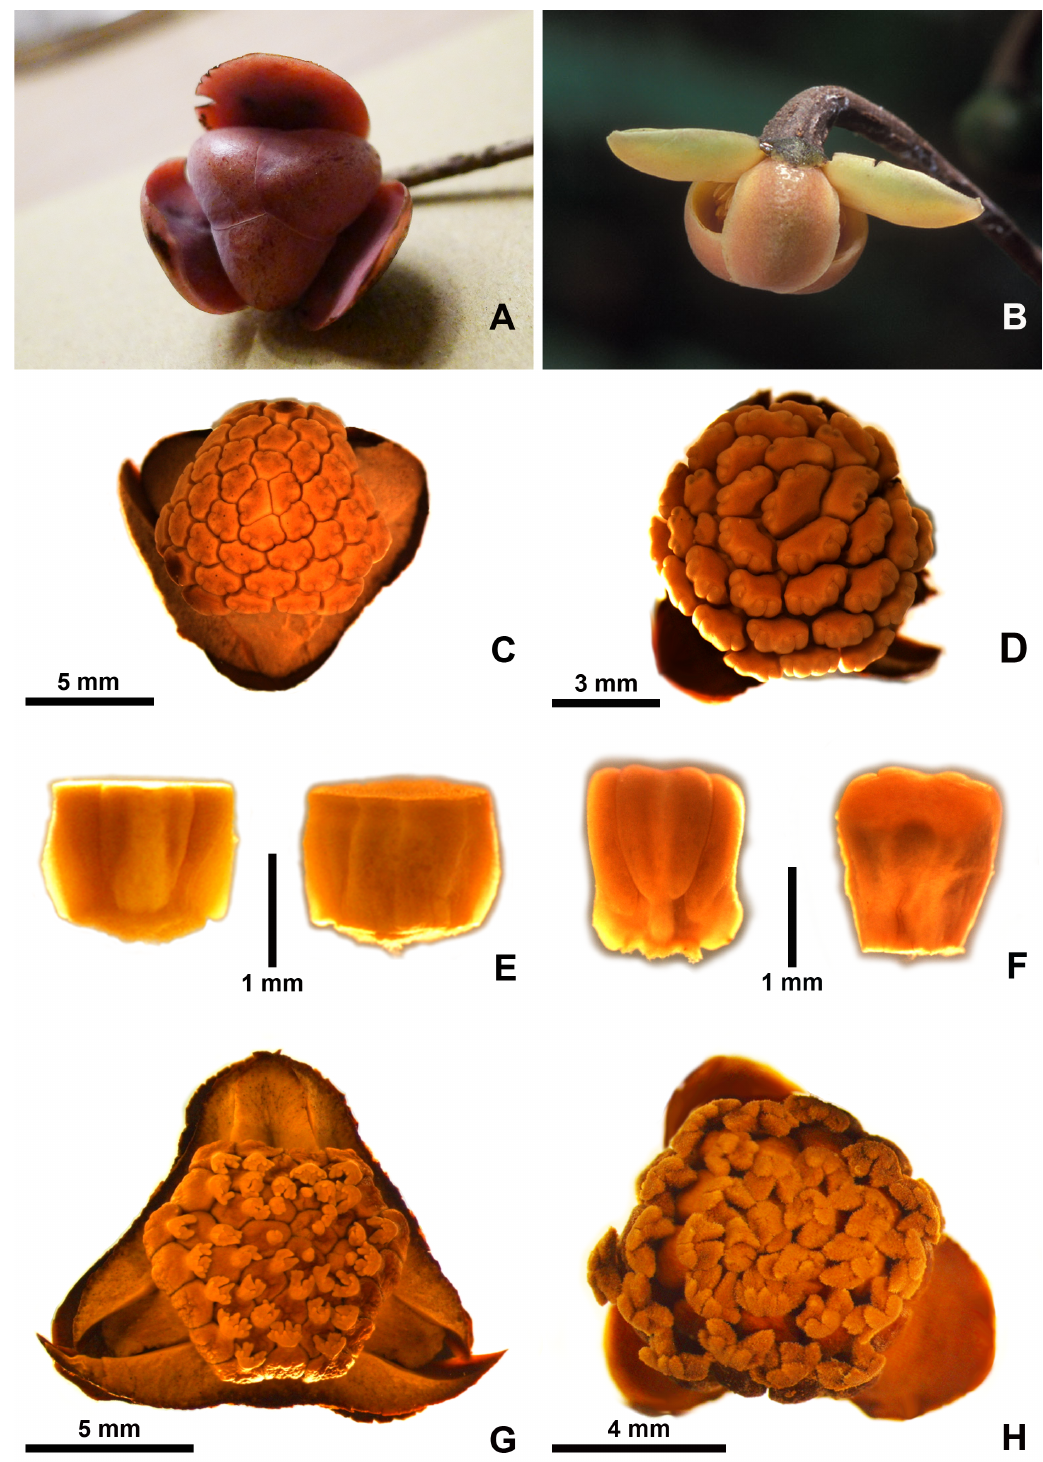
Fig. 3. Flowers and floral organs of Winitia cauliflora (Scheff.) Chaowasku ( A , C , E , G ) and Winitia longipes (Craib) Chaowasku & Aongyong comb. nov. ( B , D , F , H ). A–B . Flowers. C–D . Male flowers with petals removed. E–F . Stamens, abaxial (left) and adaxial (right) sides. G–H . Female flowers with petals removed. A, C, E, G from Chaowasku 185 (CMUB); B from Gardner et al. ST1665 (L); D, F, H from Aongyong 8 (CMUB). Photographs by T. Chaowasku (A) and S. Gardner